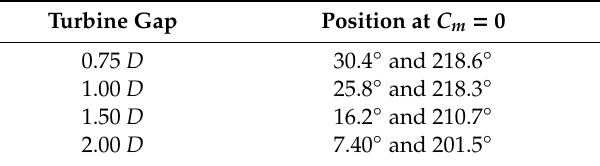
Figure 11. Instantaneous coefficients of torque on a single blade at different gaps. Table 3. The position at which the torque coefficient falls to zero.